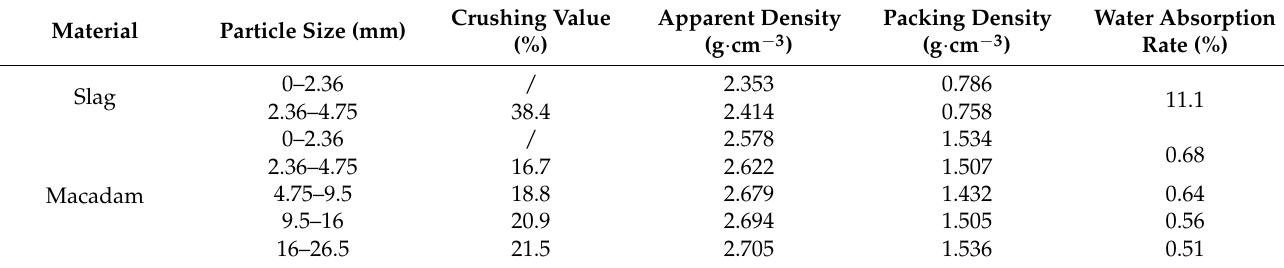
Table 2. Physical and mechanical properties of slag and macadam.